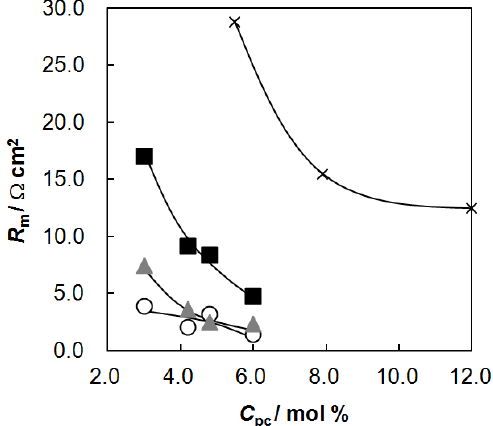
Figure 4. Membrane resistance, R the anion-exchange groups, C Figure